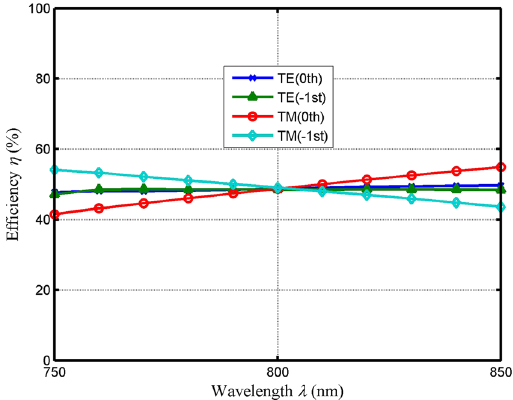
Figure 2. Efficiency versus the incident wavelength in the 0th and the − 1st orders for both TE and TM polarizations at a duty cycle of 0.65 and an incident angle of 20.71°.